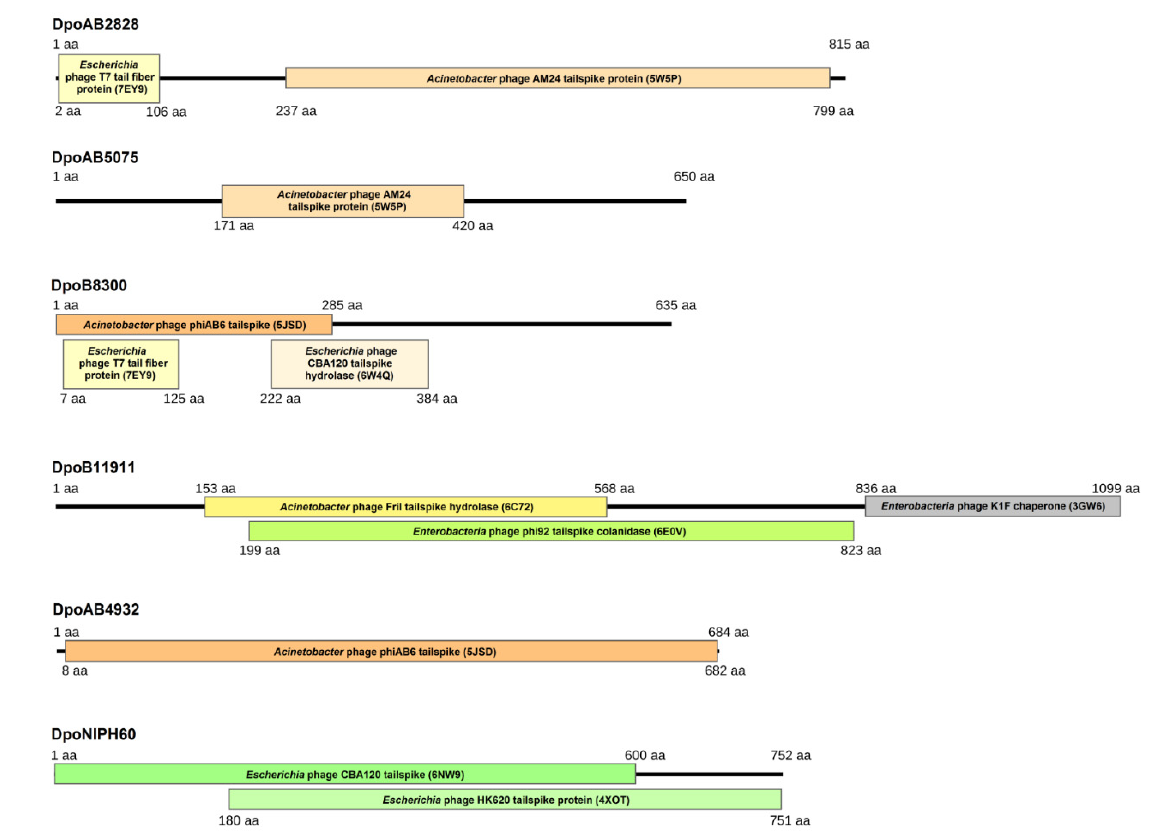
Figure 2. HHpred-detected structural similarities between prophage-derived depolymerases and proteins from the PDB databases.